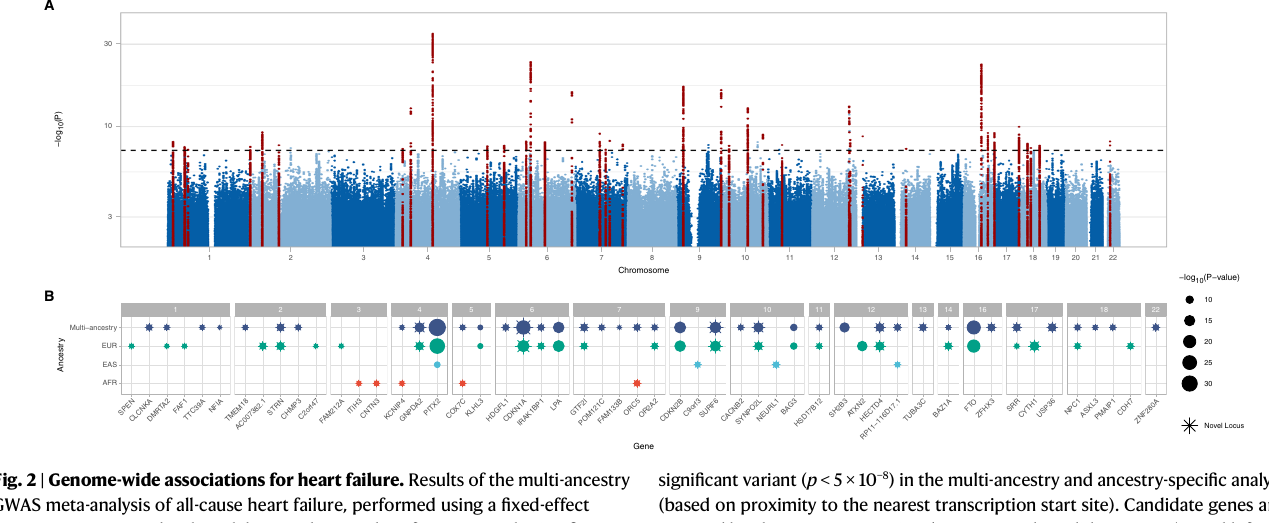
signi fi cant variant ( p <5×10 − 8 ) in the multi-ancestry and ancestry-speci fi c analyses (based on proximity to the nearest transcription start site). Candidate genes are groupedby chromosome.Previouslyunreported candidate genes (>500kb from a previouslyreportedlocus)aredenotedbystars.Thesizeofeachpointcorresponds to the strength of association as represented by − log 10 ( p value). Where multiple independent variants mapped to the same gene, only the strongest association is